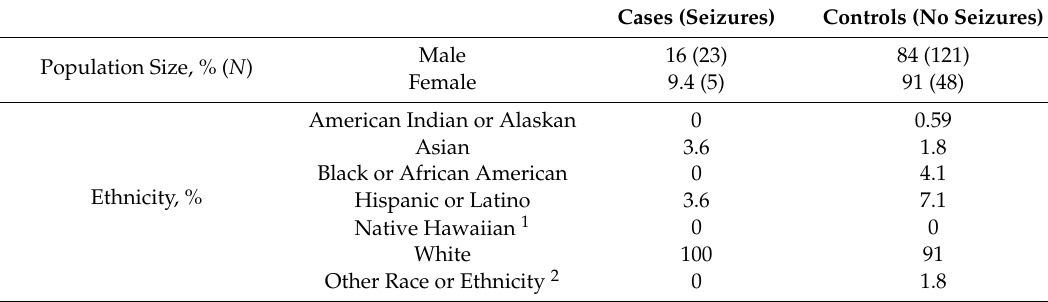
Table 3. Characteristics of the FXS